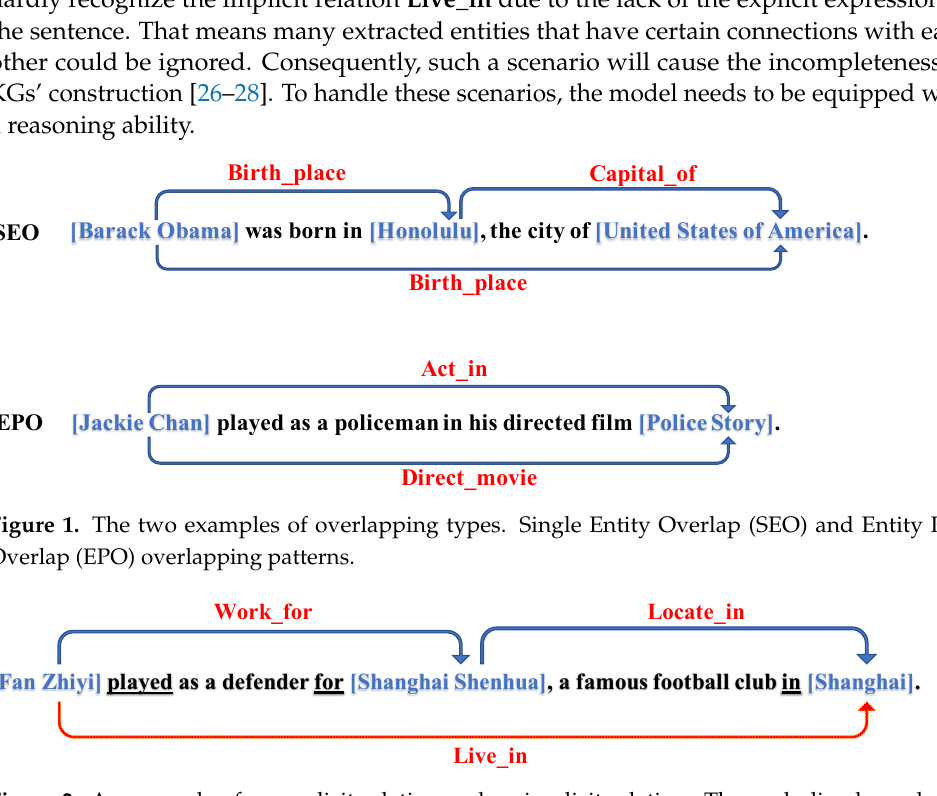
Figure 2. An example of an explicit relation and an implicit relation. The underlined words are context words. The red arrow line means the implicit relation between entity pairs without explicit context words in a